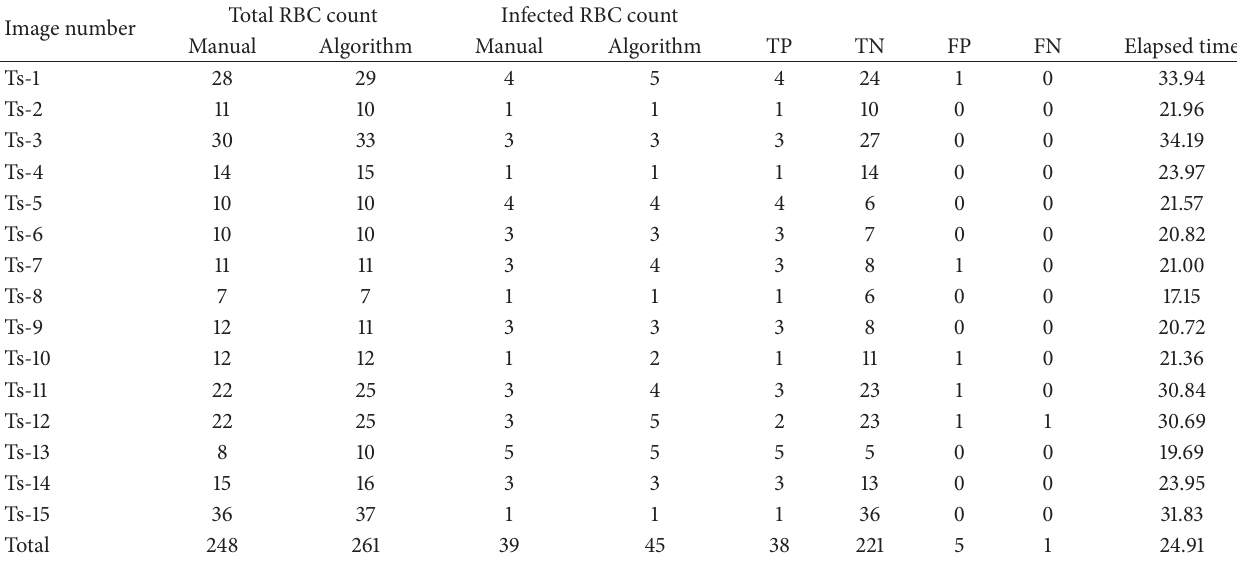
Table 4: Calculations of total RBC, infected RBC, and the TP, TN, FP, and FN values considering all the seven